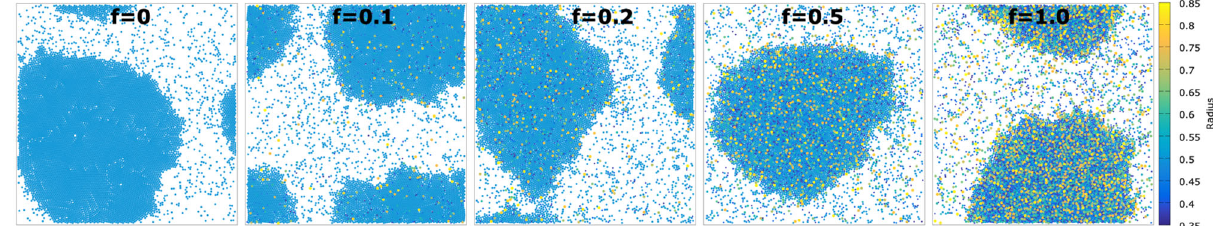
Fig. 3 Representative stationary con fi gurations in motility-induced phase separation. Snapshots of mixture of Active Brownian particles composed by a fraction f of polydisperse disks ( ℓ = 100, ϕ = 0.44, L = 120 〈 σ 〉 ). Particle colors indicate their